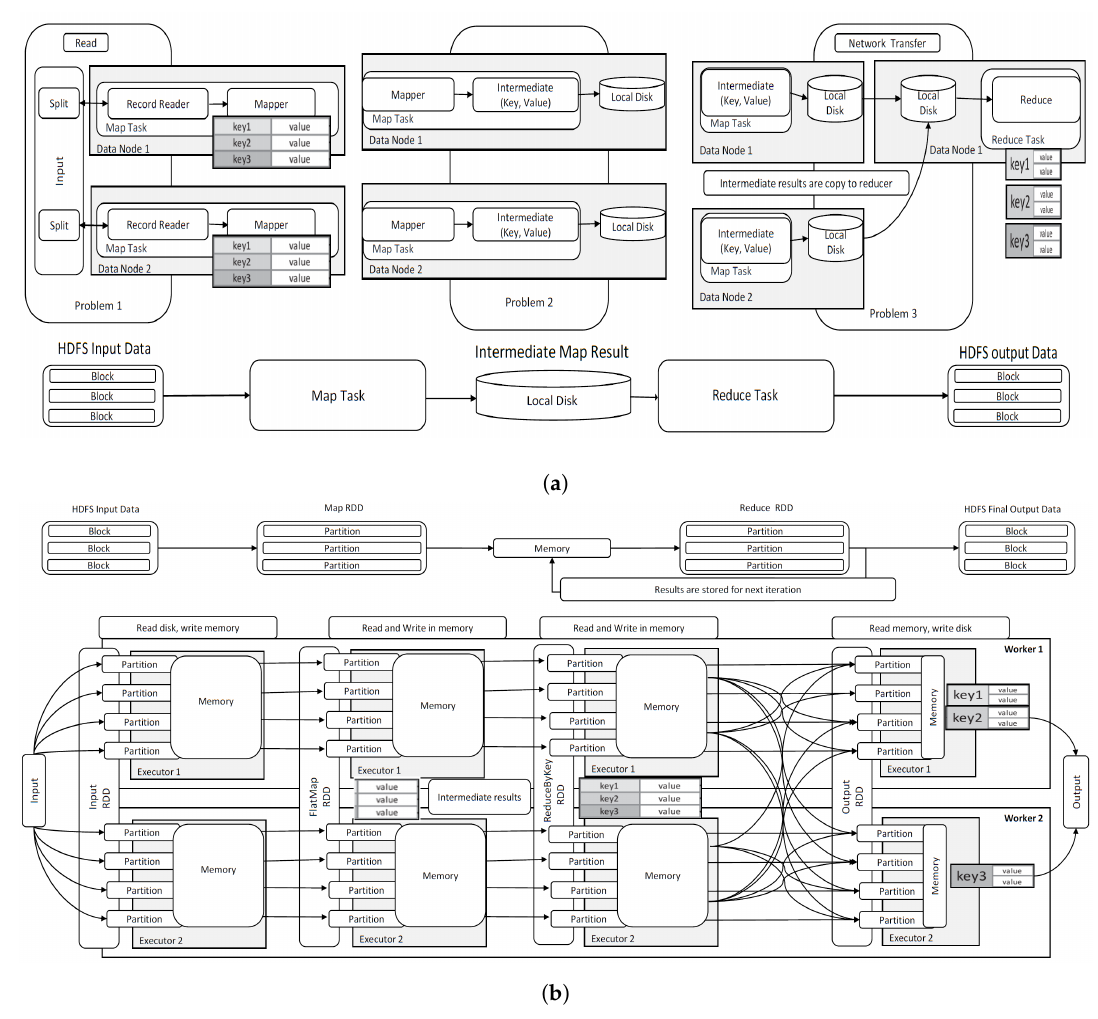
Figure 1. Comparing the components and Data-flow in MapReduce and Spark structures. ( a ) MapReduce structures; ( b ) Spark